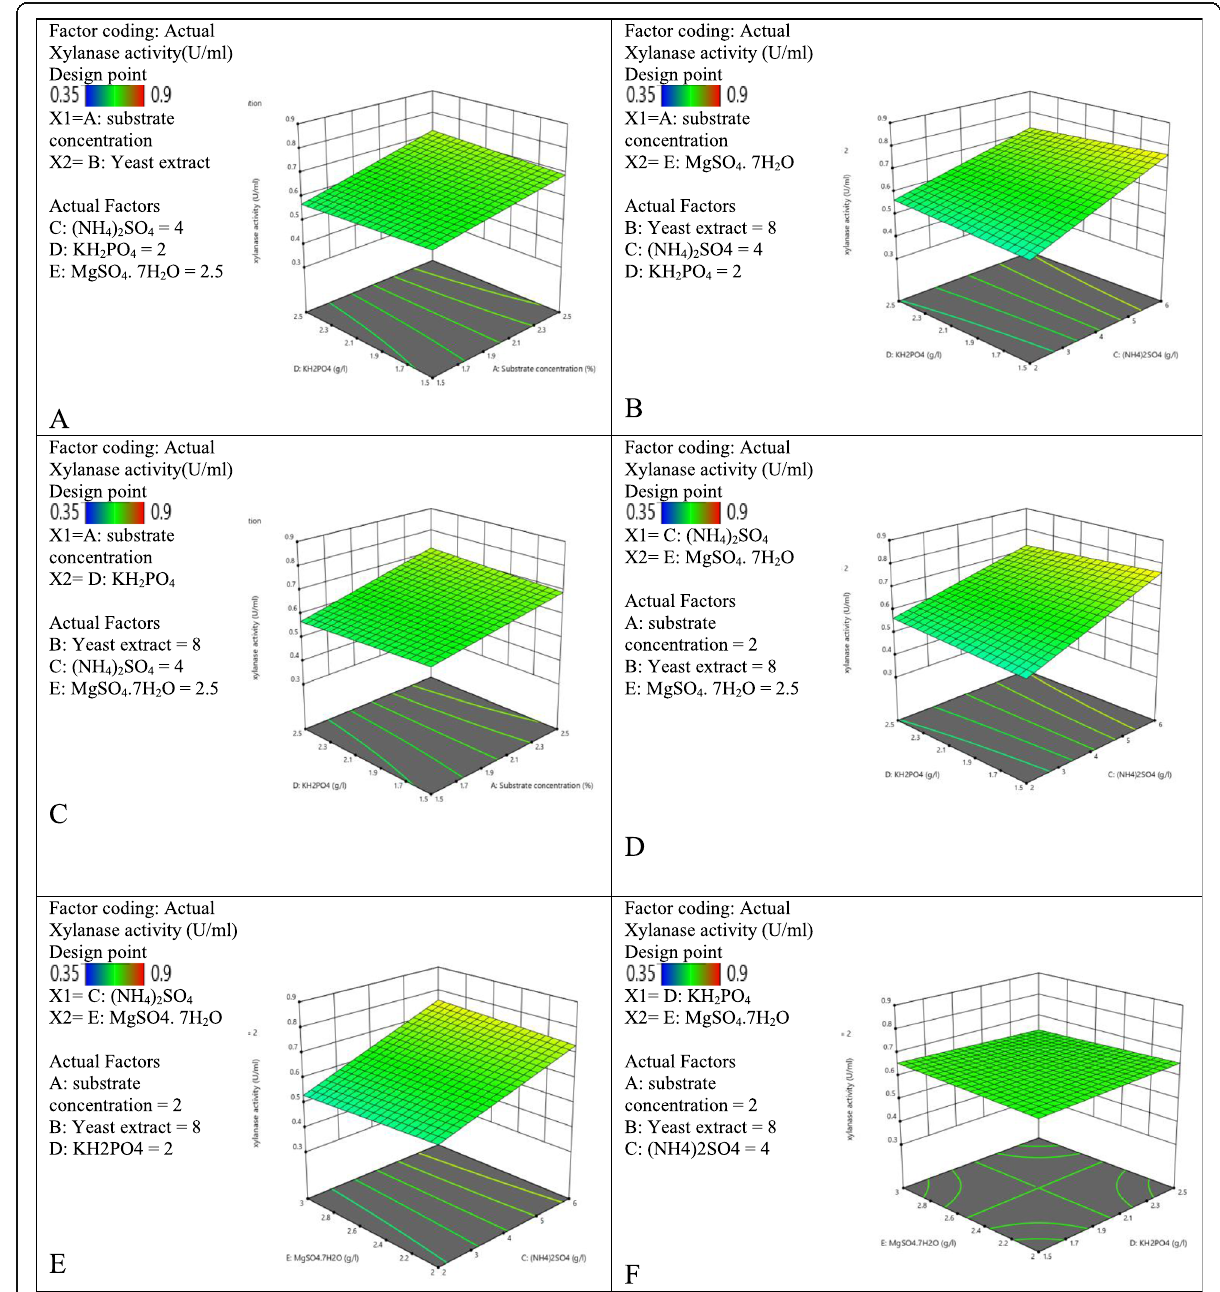
Fig. 5 3D surface plot showing the interaction between significant factors affecting xylanase production. a Substrate concentration and yeast extract. b Substrate concentration and MgSO4. 7H 2 O. c Substrate concentration and KH 2 PO 4 . d (NH4) 2 SO 4 and KH 2 PO 4 . e (NH4) 2 SO 4 and MgSO4. 7H 2 O. f KH 2 PO 4 and MgSO 4 . 7H 2